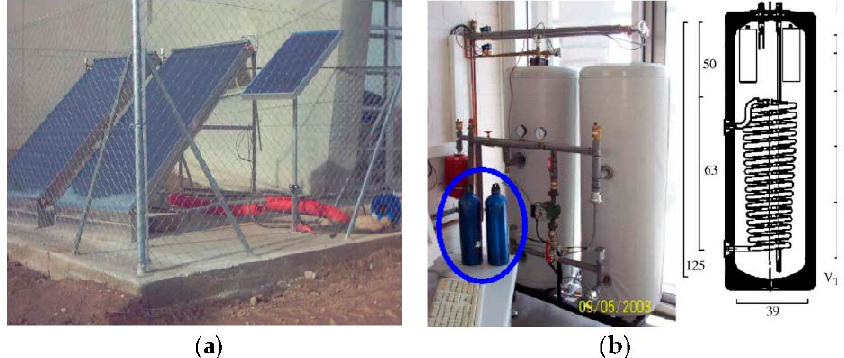
Figure 3. ( a ) Solar thermal collectors ( b ) Hot-water tanks with PCM modules. Reproduced with permission from [74]. Elsevier: Solar Energy Materials and Solar Cells, copyright 2006.